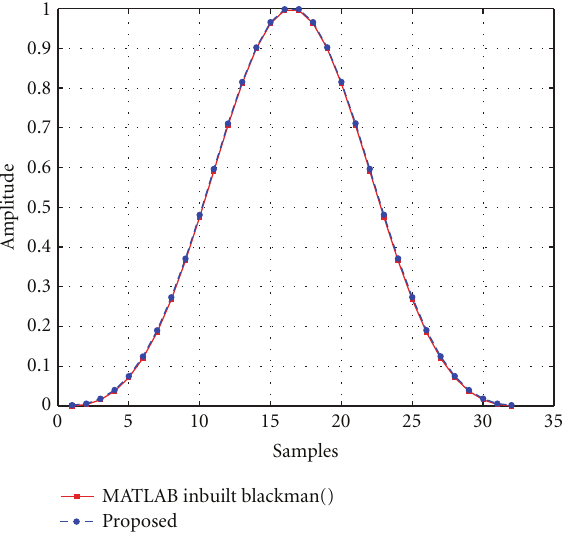
Figure 7: Comparison of proposed window implementation with MATLAB inbuilt blackman() function for N =